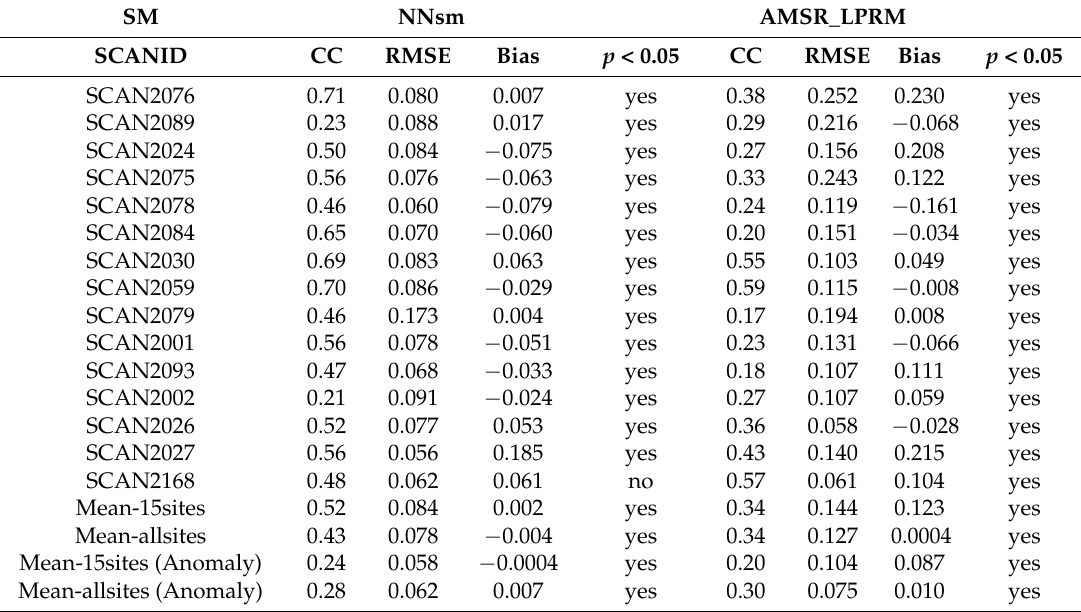
Table 3. Comparative results for NNsm and AMSR_LPRM against in situ SCANsm (selected 15 sites) for the 2003–2015 period. The mean value is computed only when the correlations are significant correlations ( p -value <